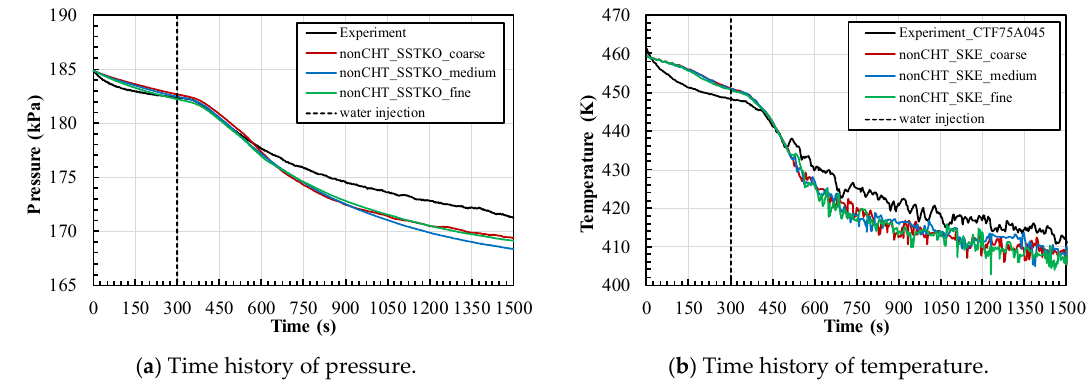
Figure 6. Comparison of the measured pressure and temperature (black lines) with the numerical CFD on the coarse mesh (red lines), medium mesh (blue lines), and fine mesh (green lines).